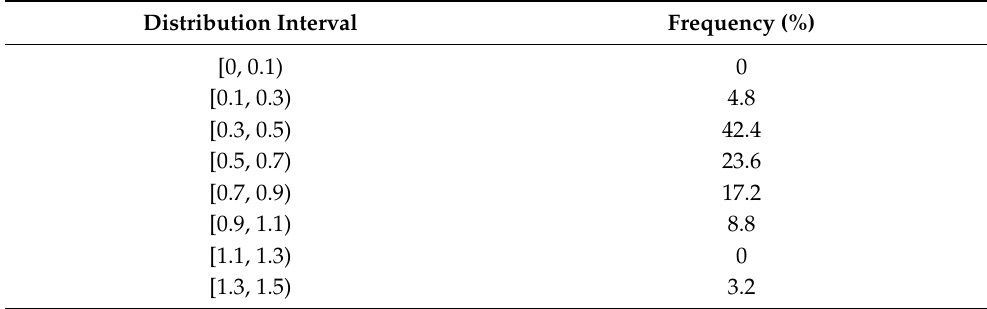
Table 4. Distribution frequency of the path module correlation coefficients between two modules including 10, 50, 100, 150, 200 nodes. All of the coefficients fall into the [0.1, 1.5) interval, most coeffi- cients fell into the [0.3, 0.9) interval, and a small number of coefficients fell into the [0.9, 1.5)